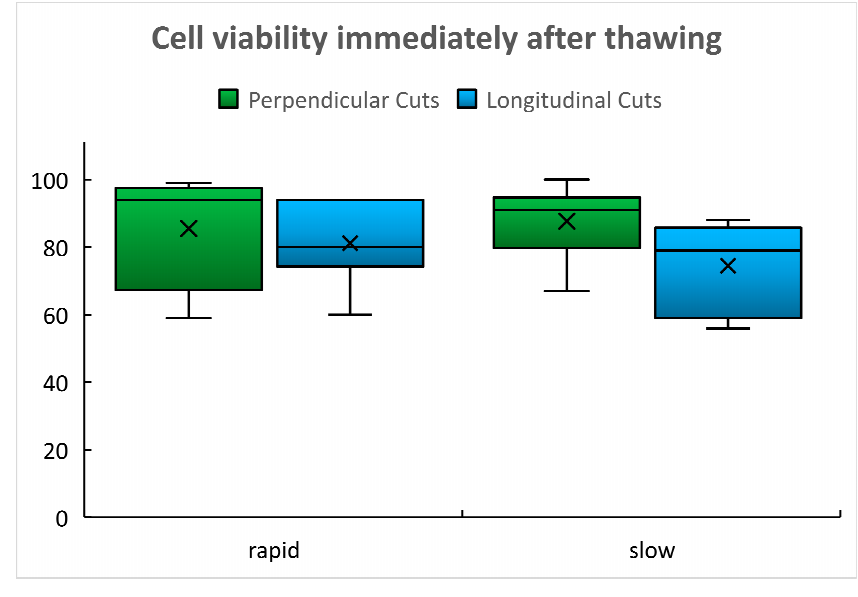
Figure 1. Immediate post-thaw cell viability (%).